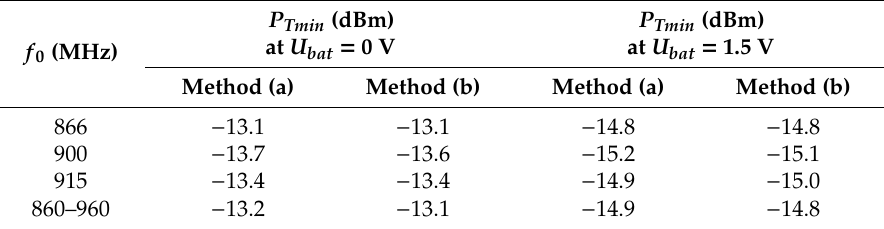
Figure 15. Examples of research results: ( a ) Real part of chip impedance Z TC ; ( b ) Imaginary part of chip impedance Z TC . P T —power transferred to chip; P Tmin —chip sensitivity. Table 5. Examples of research results: chip sensitivity vs. frequency and U bat .